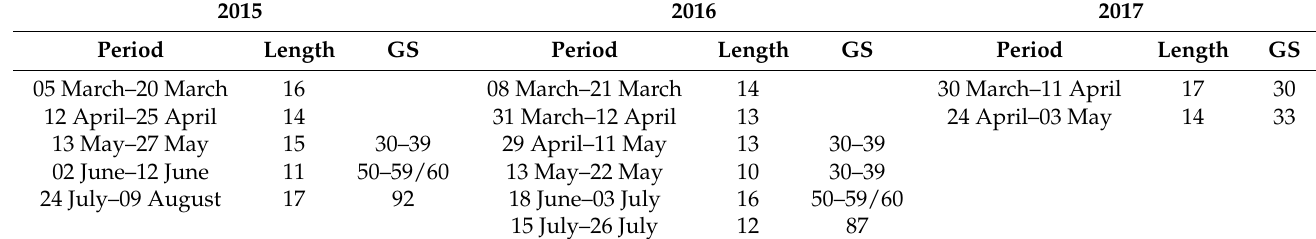
Table 4. Dry periods during yield-relevant phenological growth stages (GS) of winter wheat in 2015 to 2017.